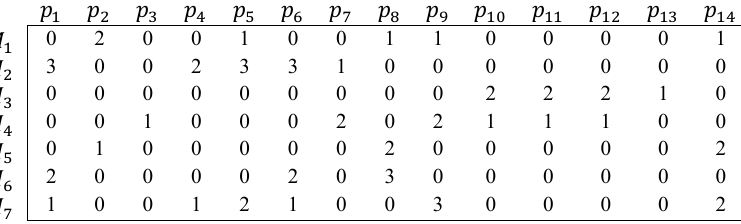
The results of comparison of GA versus optimal solution using Lingo software